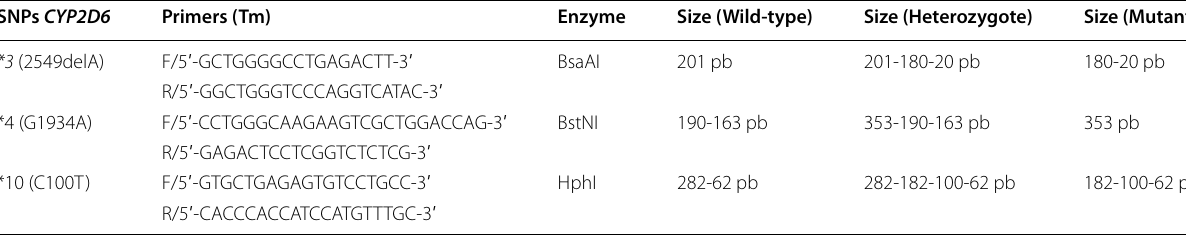
Table 1 Primers and restriction enzymes used for genotyping SNPs CYP2D6 Primers (Tm)